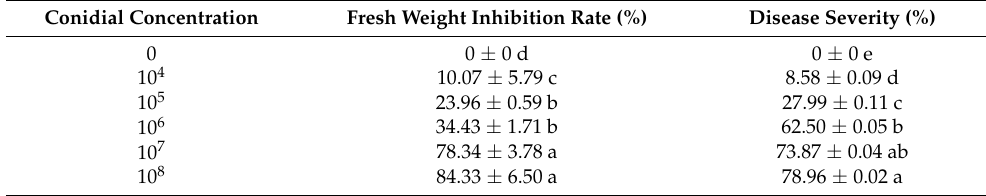
Table 3. Effect of the concentration of the C. echinochloae B-48 inoculum on weed control. Conidial Concentration Fresh Weight Inhibition Rate (%)